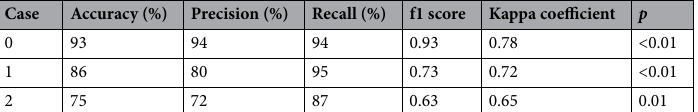
Table 9. 1-D CNN with attention model results.